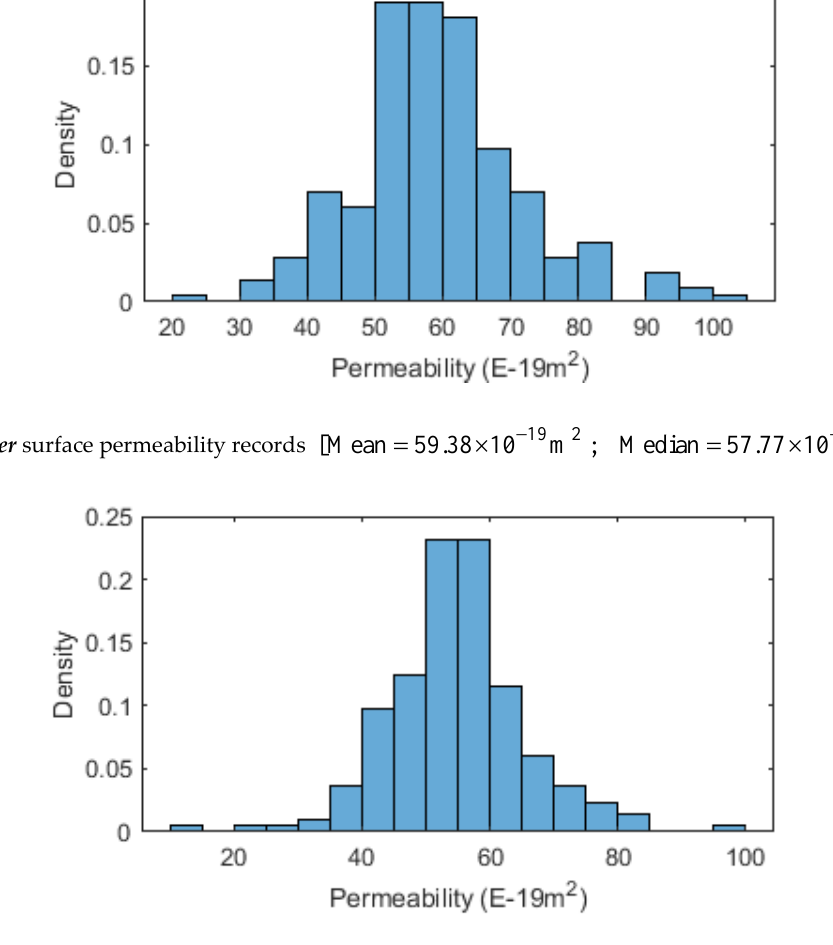
Figure 14. Spatial permeability probability density histogram for the Stanstead granite derived using the kriging procedure on the Higher and Lower surface permeability records.